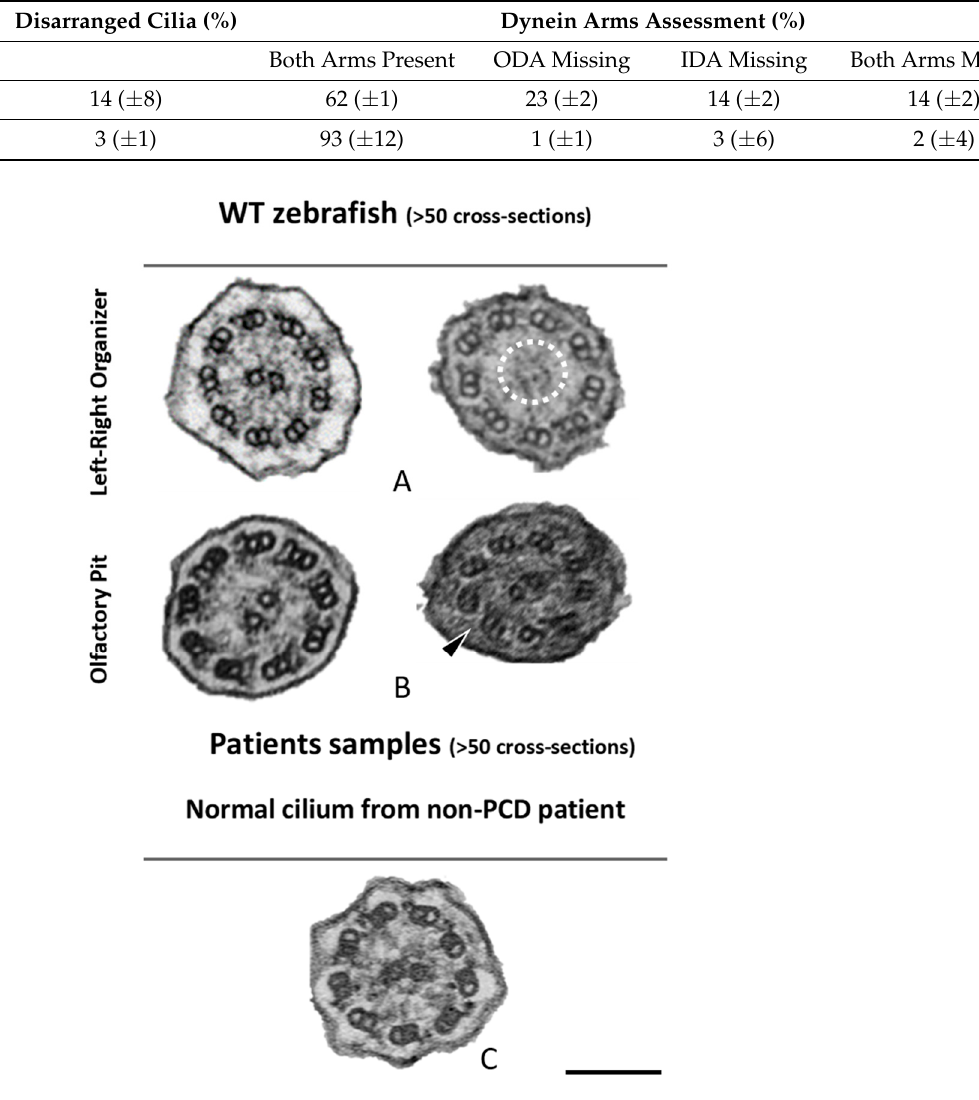
Figure 5. Ciliary ultrastructural comparison between the LRO, OP and human respiratory cilia. Variations of the ax- onemal arrangement of cilia in ( A ) the LRO of 10 somite stages WT zebrafish embryo and ( B ) the OP of 5 dpf WT zebrafish larvae. ( C ) Example of a human respiratory cilium cross-section from the airway. Arrowheads indicate missing ODA and the dotted circle shows missing CP. Scale bar 100nm